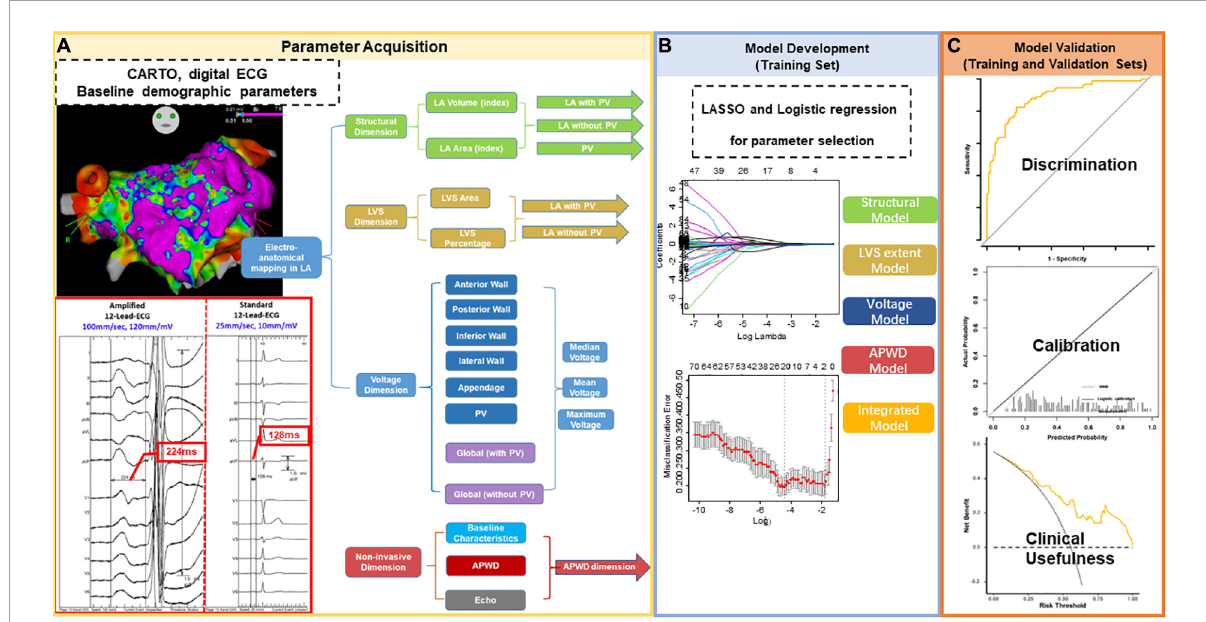
FIGURE1 Study Flowchart. The study comprised three major steps. Step 1 for parameter acquisition (A) was performed in all enrolled participants with extraction of data from LA electro-anatomical mapping (LA structure, LVS extent, and LA voltage) and non-invasive parameters (ECG and clinical baseline characteristics, echocardiography). Extracted data were categorized into four categories/dimensions [ (A) : structural dimension (green), LVS dimension (brown), voltage dimension (blue) and non-invasive parameters (red)]. The measurement of APWD in comparison to standard PWD from the same ECG at the same beat is illustrated in the red box in (A) . In contrast to standard setting (scale at 10 mm/mV and sweeping speed at 25 mm/s), the duration of P-wave in the current study (APWD) is measured at an amplified scale (60–120 mm/mV and 100 mm/s), which enables an improved accuracy in quantifying bi-atrial conduction time. Step 2: model development (B) was performed in the training set using LASSO and logistic regression for selecting the most relevant parameters for AF-persistency from each of the four different categories/dimensions. The selected parameters were used to construct diagnostic models and to undergo model validation [Step 3 in (C) ] in both training and validation sets. LA, left atrial; LVS, low voltage substrate; ECG, electrocardiogram; APWD, duration of the amplified digital P-wave; LASSO, least absolute shrinkage and selection